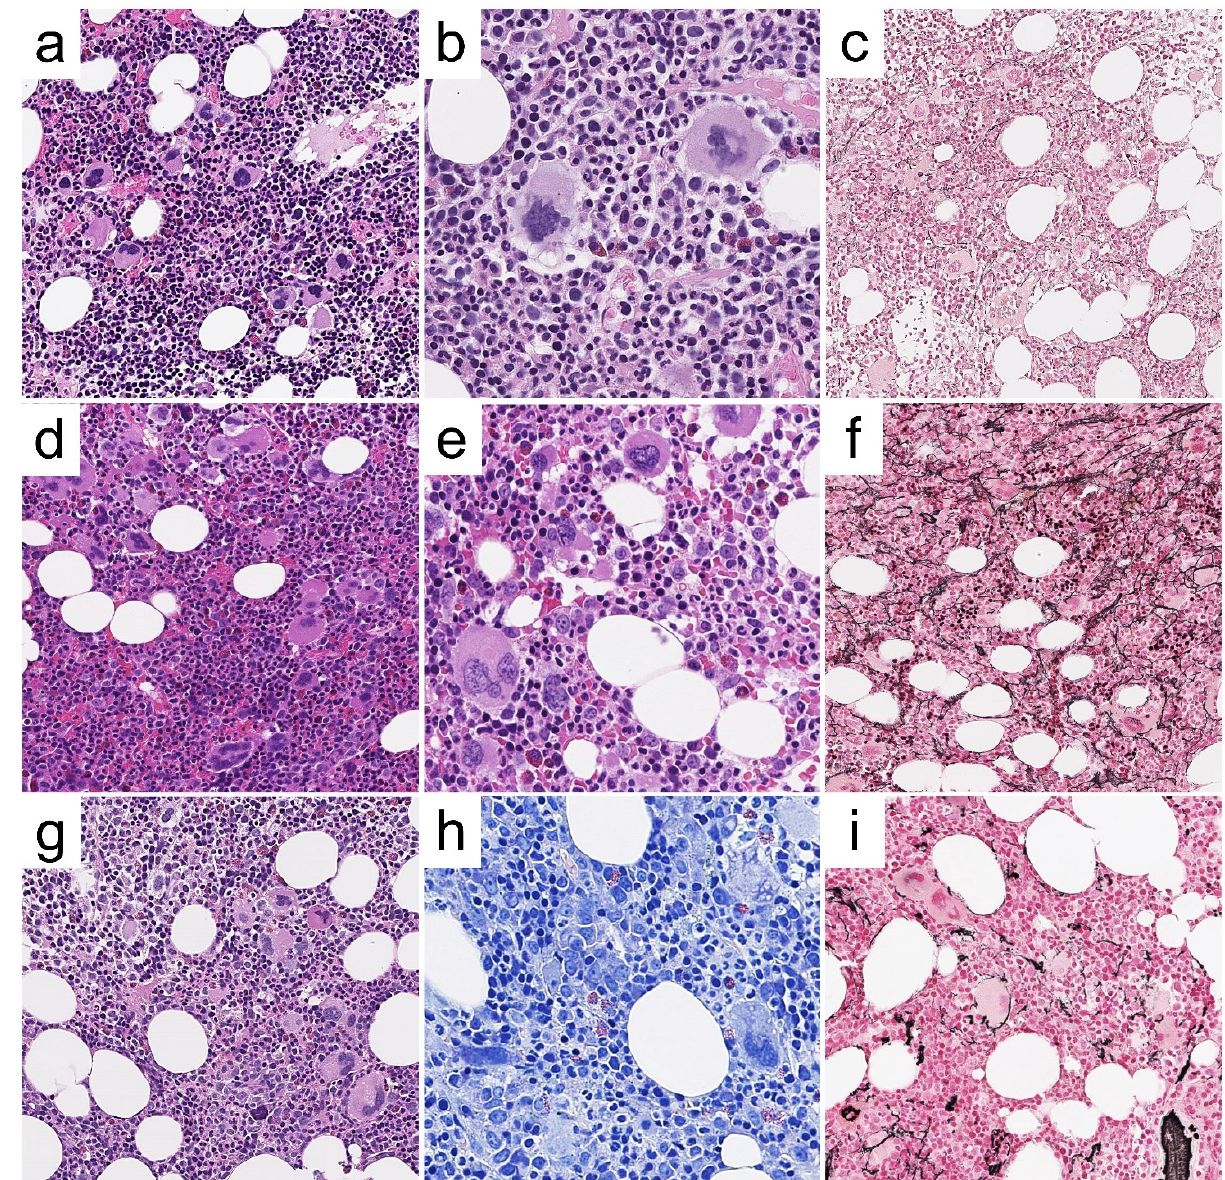
Figure 3. Representative histological features of case #2, #3 and #4. BM biopsy from case #2 ( a – c ) shows a hypercellular marrow with panmyelosis and loose clustering of megakaryocytes ( a ; H/E, 200 × ), featuring giant, hyperlobulated forms ( b ; H/E, 400 × ); reticulin network is unremarkable ( c ; Gomori silver stain, 200 × ). BM biopsy from case #3 ( d – f ) depicts hypercellularity with panmyelosis and loose to denser clustering of megakaryocytes ( d ; H/E, 200 × ), which range in morphology from small/hypolobulated to large/hyperlobulated ( e , H/E, 400 × ); a minor increase in reticulin network, consistent with MF-1 grade is observed ( f ; Gomori silver stain, 200 × ). BM biopsy from case #4 ( g – i ) features panmyelosis and loose clustering of megakaryocytes with small to giant, hyperlobulated forms and naked nuclei ( g ; H/E, 200 × ); megaloblastoid features of erythropoiesis are best appreciated with Giemsa stain ( h ; 400 × ), whereas Gomori stain is unremarkable ( i ; 200 ×